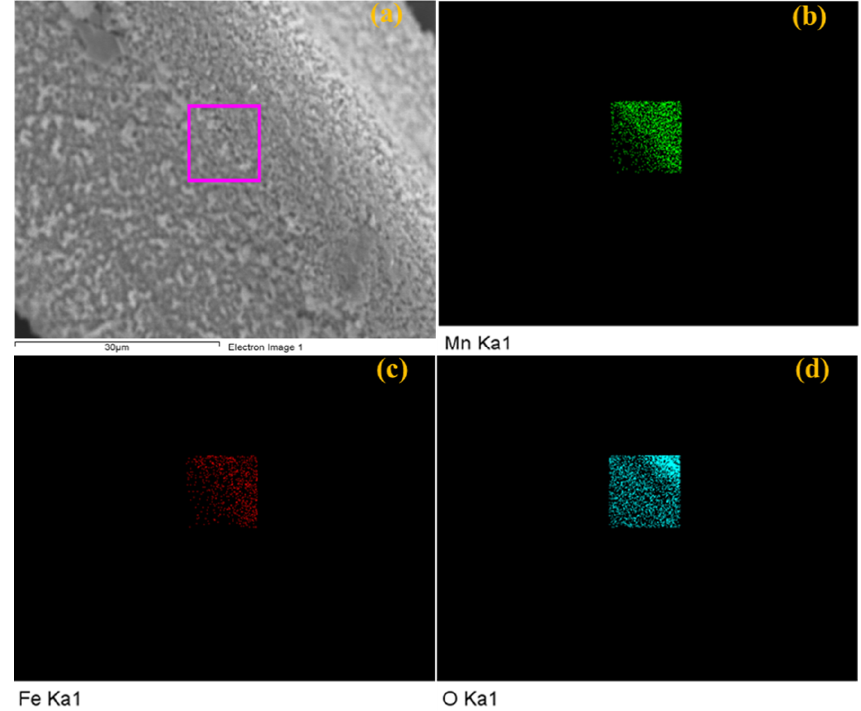
Figure 3. EDS element mapping of the MnFe-LDH electron image ( a ), manganese ( b ), iron ( c ), and oxygen ( d ).